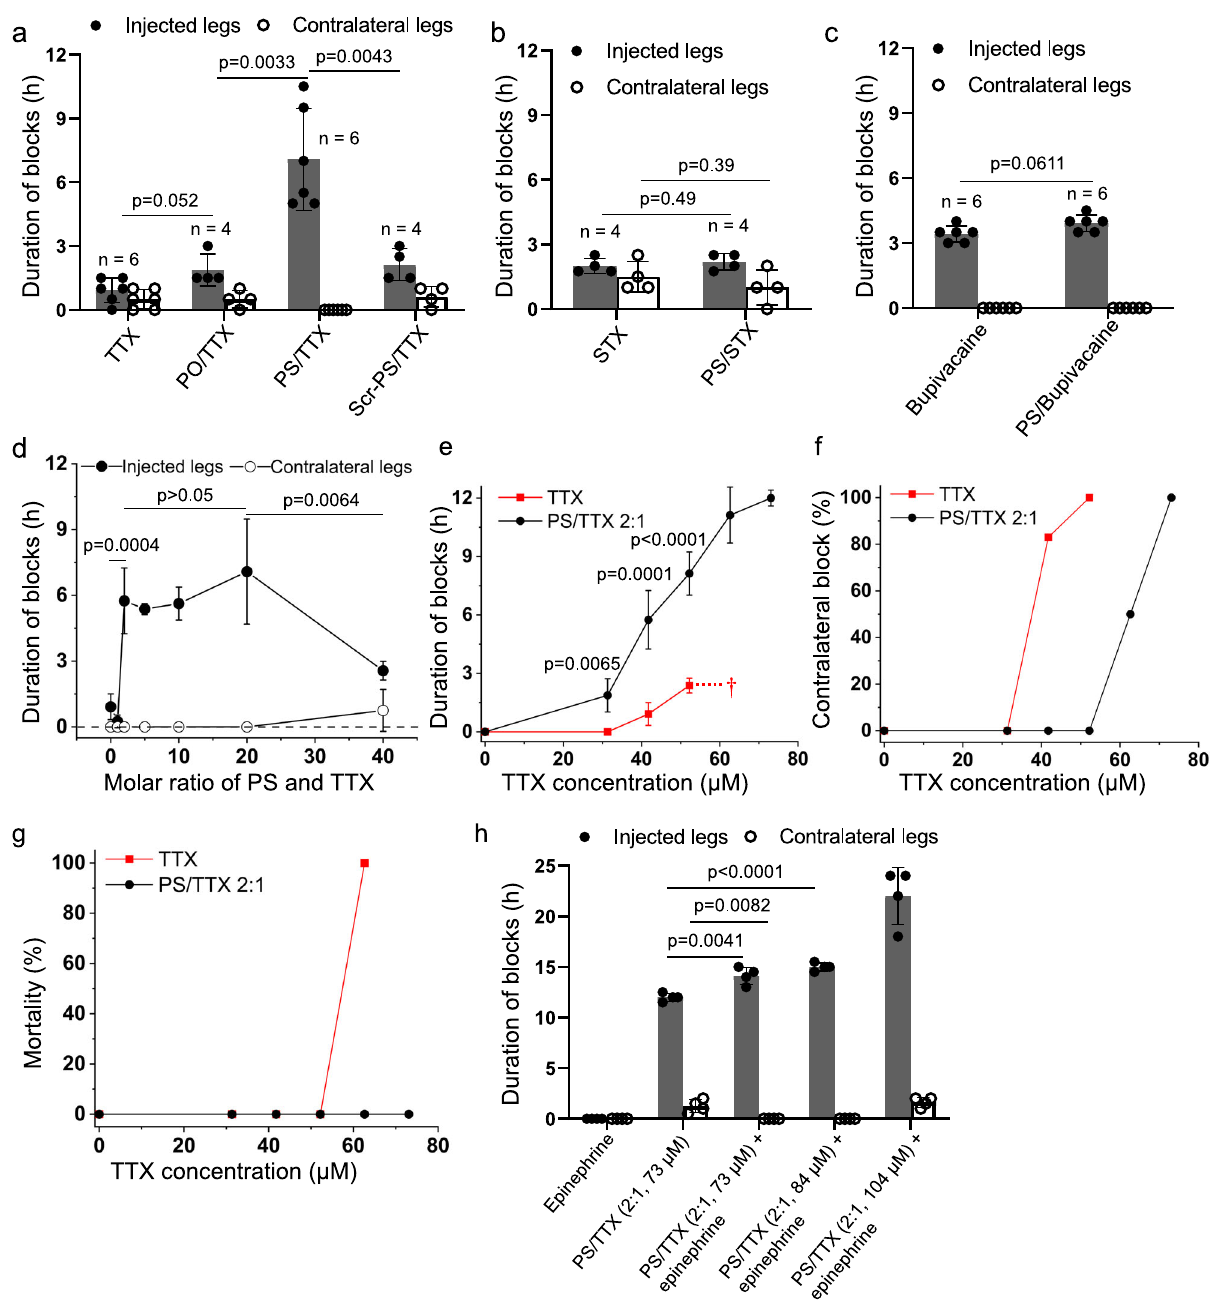
Fig. 2 | Peripheral nerve block with PS/TTX complexes. a Peripheral nerve blockade with 42 µ M TTX, free or complexed with aptamers (PO, PS, Scr-PS) ( n =6 biologically independent animals for TTX and PS/TTX; n =4 biologically indepen- dent animals for PO/TTXand Scr-PS/TTX). b Peripheral nerve blockade with 22 µ M STX alone or combined with the TTX-speci fi c PS aptamer ( n =4 biologically inde- pendent animals for STX and PS/STX). c Peripheral nerve blockade with bupiva- caine alone or combined with the TTX-speci fi c PS aptamer ( n =6 biologically independent animals for bupivacaine and PS/bupivacaine). The bupivacaine con- centration in each formulation was 15.4mM. d Peripheral nerve blockade with varying molar ratios of PS/TTX complexes, using 42 µ M TTX. Data are means±s.d. ( n =6 biologically independent animals forTTX and PS/TTX 20:1; n =4 biologically independentanimalsforPS/TTX1:1,2:1,5:1,10:1,and40:1). e Sciaticnerveblockade withfreeTTXandPS/TTX(2:1)intheinjectedhindpaws.Thedaggerindicates100%